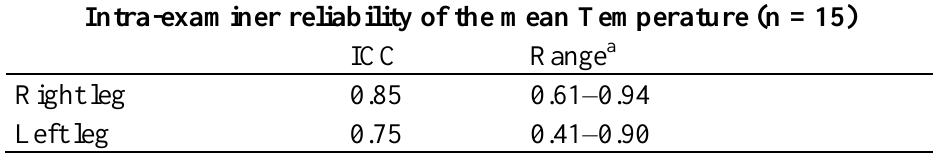
Table 2. Intra-examiner reproducibility of mean knee temperature a 95% confidence